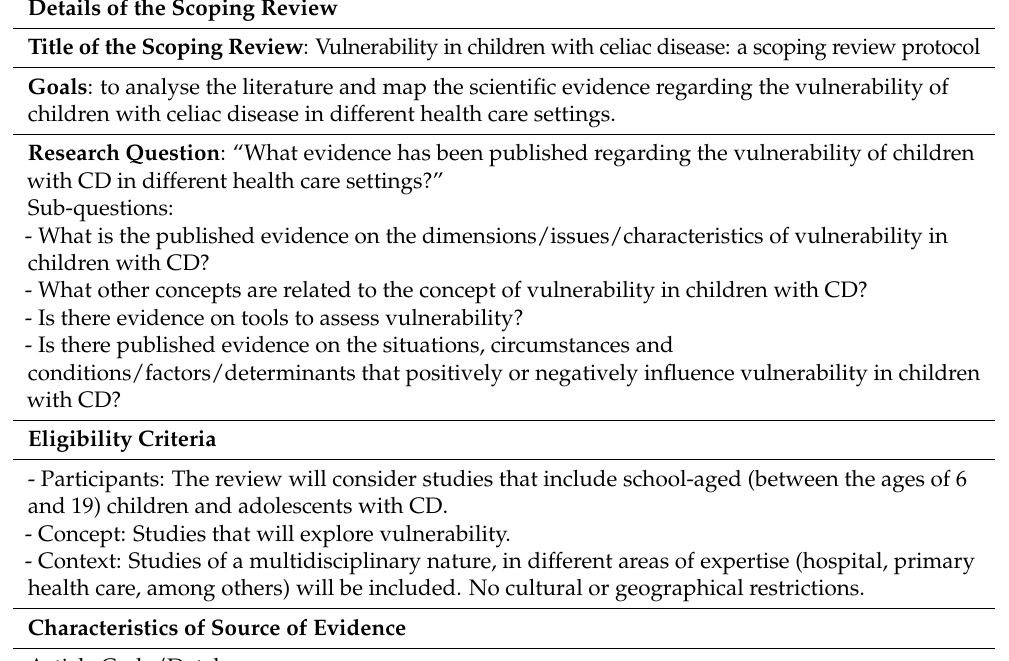
Table 2. Data extraction